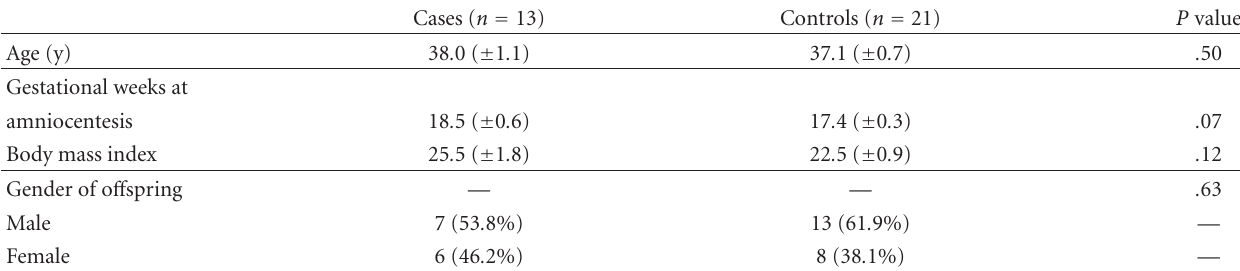
Table 1: Demographic data of participating women delivering at < 37 weeks of gestation (cases) or at term (controls) (mean ±